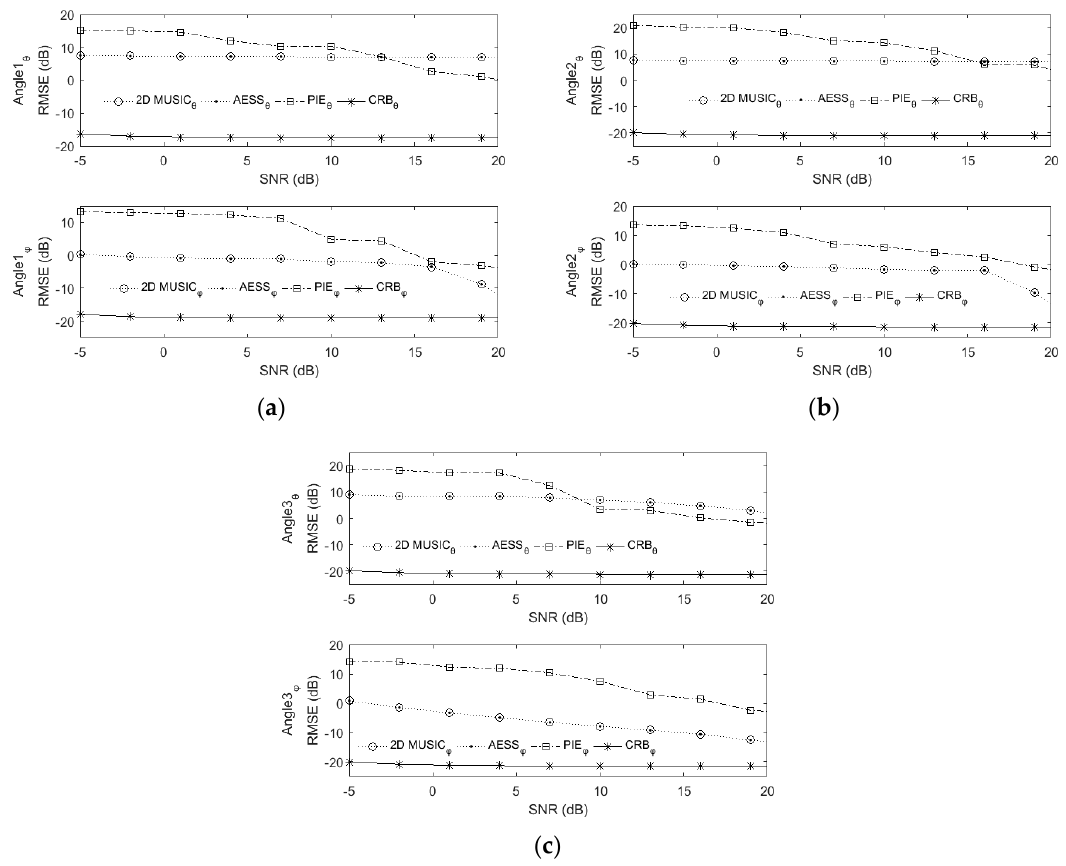
Figure 7. RMSE versus SNR. Snapshot is set to be 400, stepsize is set to be 0.1 ◦ . ( a ) The first source come from ( 20 ◦ ,40 ◦ ) ; ( b ) The second source come from ( 75 ◦ ,50 ◦ ) ; ( c ) The third source come from ( 35 ◦ ,60 ◦ )